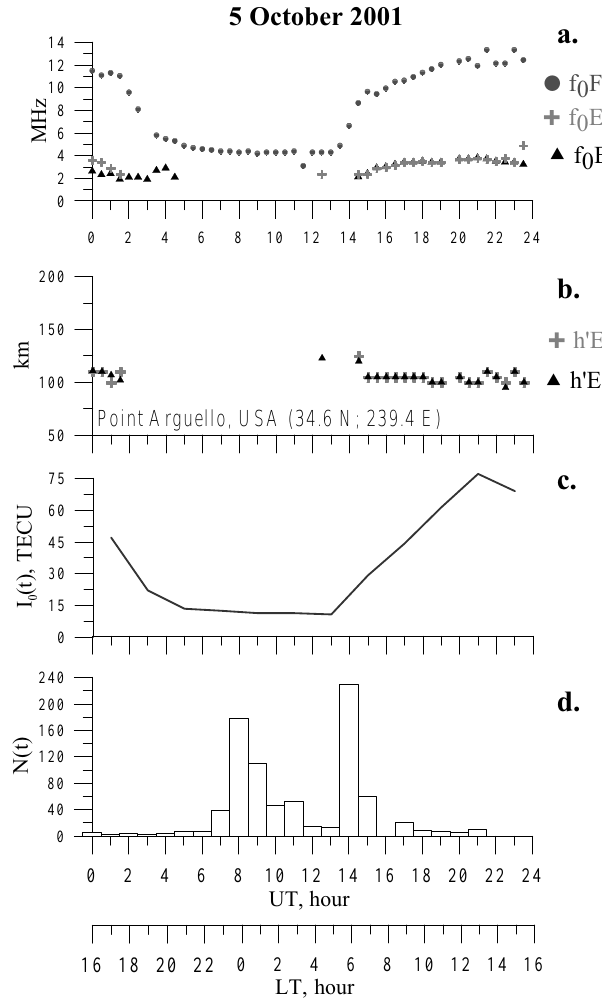
Fig. 11. (a) – Values of the critical frequencies fo F2 – heavy dots; fo E s – crosses; fo E –shaded triangles, measured on 5 October 2001 at ionospheric station Point Arguello (239.4 ◦ E; 34.6 ◦ N); (b) – vari- ations of virtual heights h 0 E – shaded triangles, h 0 E s – crosses. (c) – variations of the absolute “vertical” TEC value I 0 (t) for the site with the coordinates 240 ◦ E; 35 ◦ N, obtained from IONEX-maps of TEC; (d) – the same as Fig.